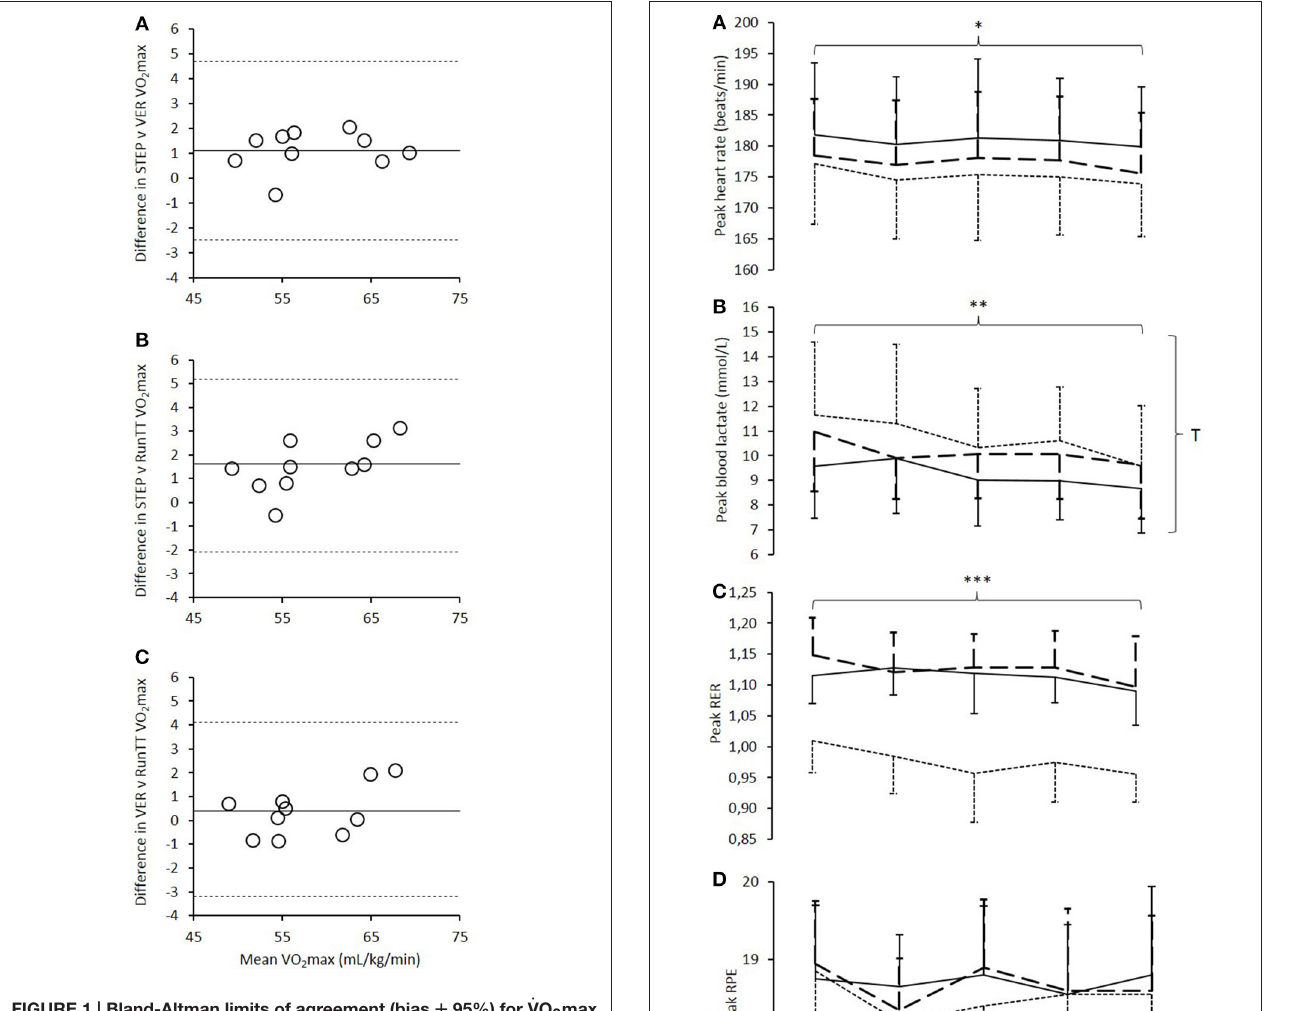
FIGURE 1 | Bland-Altman limits of agreement (bias ± 95%) for ˙ VO 2 max measured during (A) the incremental test to volitional exhaustion (STEP) and the verification phase (VER), (B) the STEP and the four-minute running time-trial (RunTT), and (C) the VER and the RunTT.